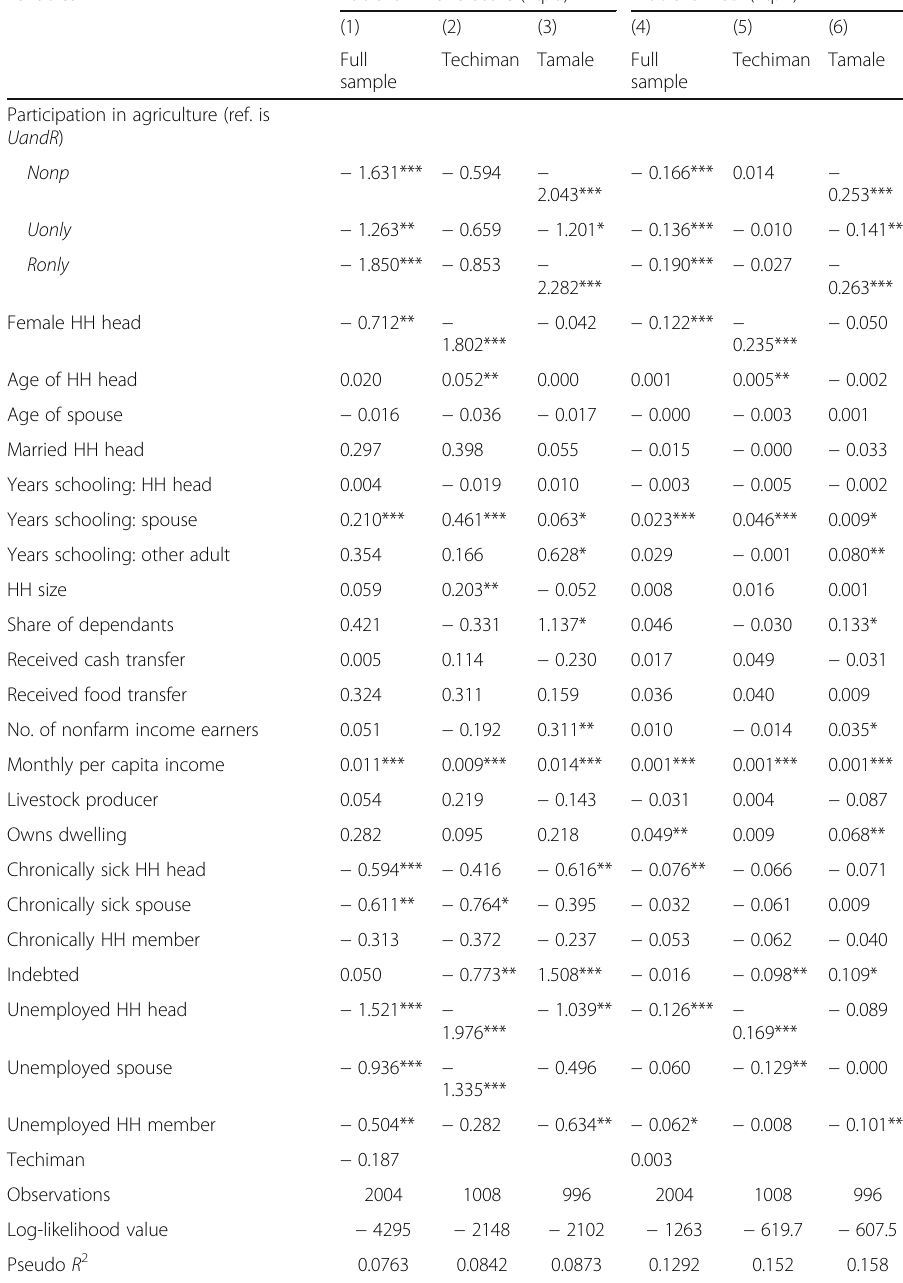
Full Techiman Tamale sample